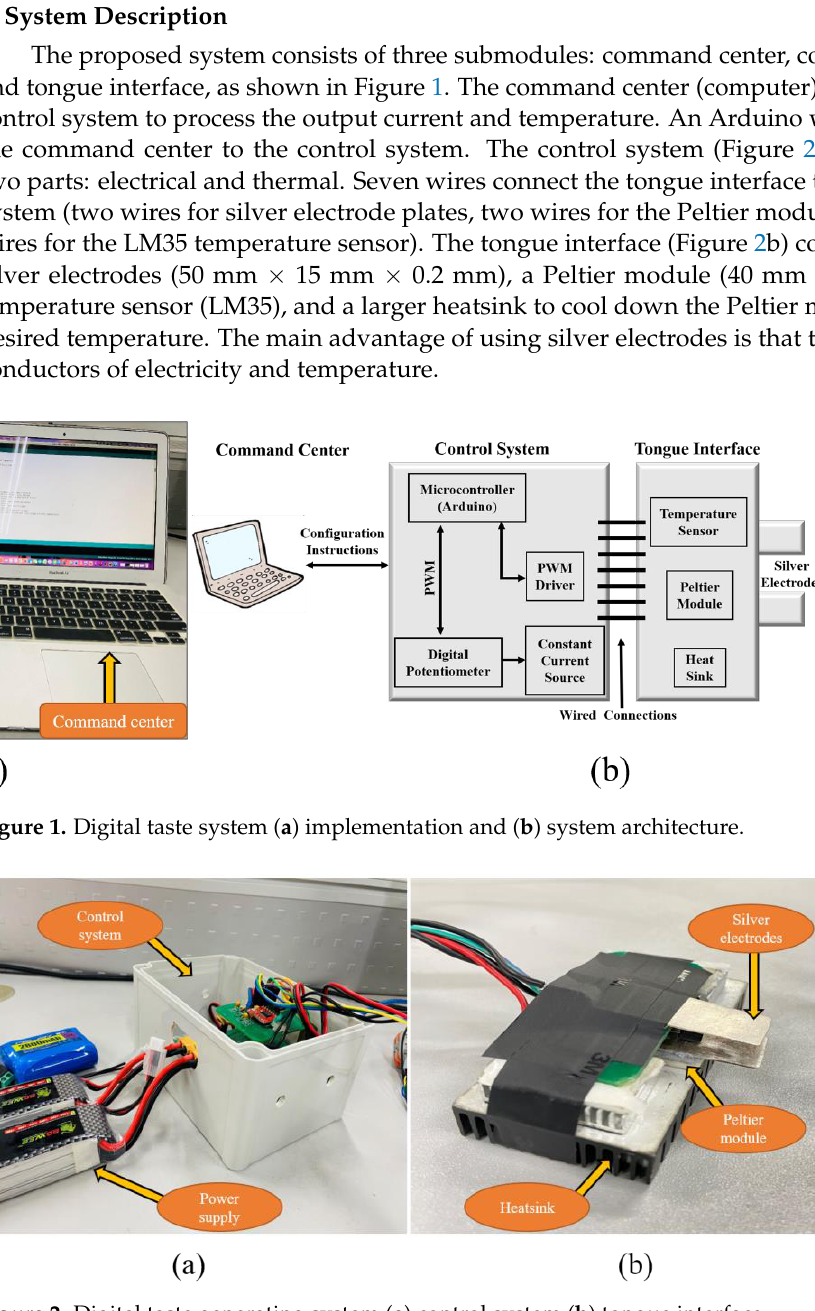
Figure 2. Digital taste generating system ( a ) control system ( b ) tongue interface.